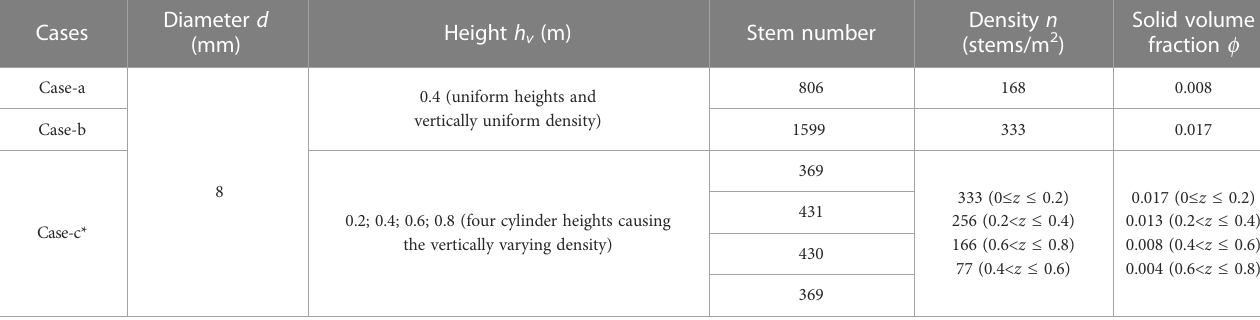
TABLE 2 Cylinder con fi gurations in experiments conducted by Chen et al. (2020) and Lou et al. (2022).